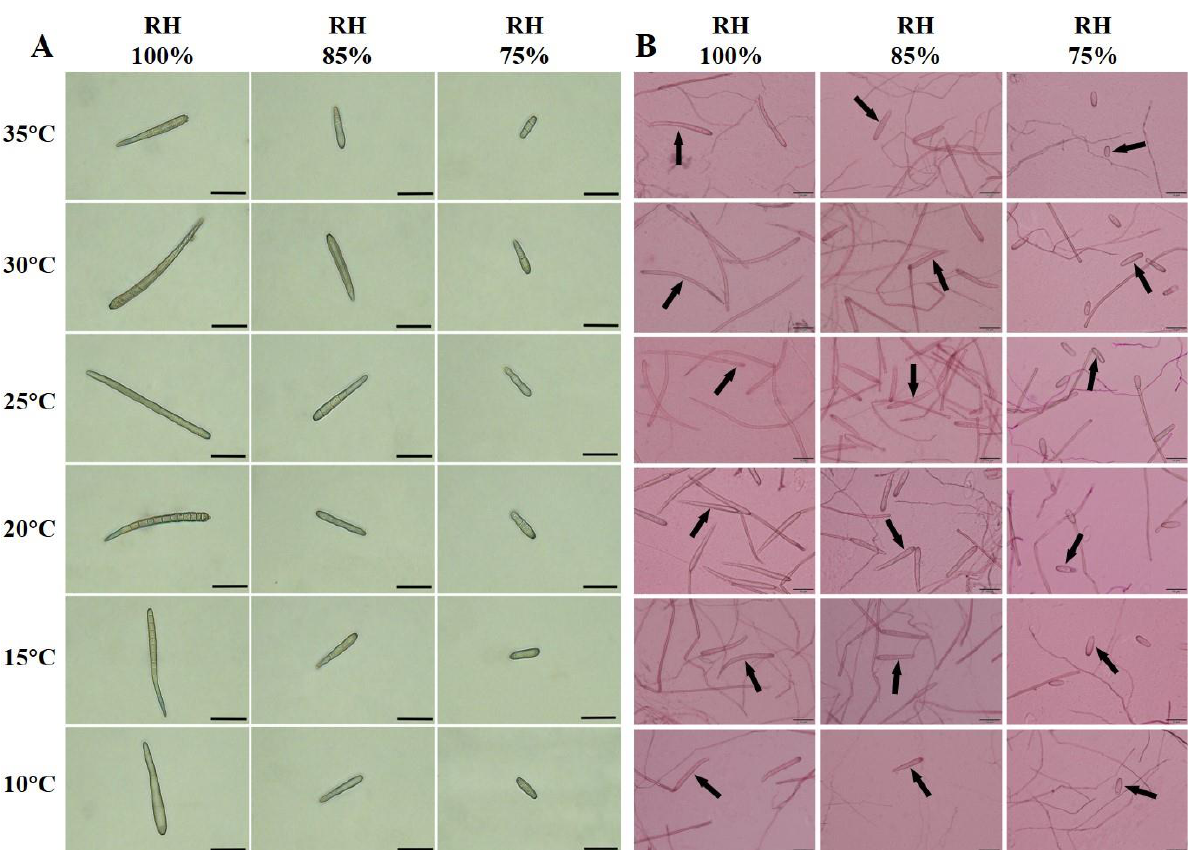
Figure 3. Morphological characteristics of Corynespora cassiicola on cucumber − leaf extract agar (CEA) ( A ) at 12 days after incubation (DAI) and cucumber seedlings ( B ) at 12 h after incubation (HAI), which were assessed at six temperatures (10, 15, 20, 25, 30, and 35 °C) with three moisture levels (75%, 85%, and 100% RH) per temperature. Black arrowheads represented the spores (Scale bars, 50 µ